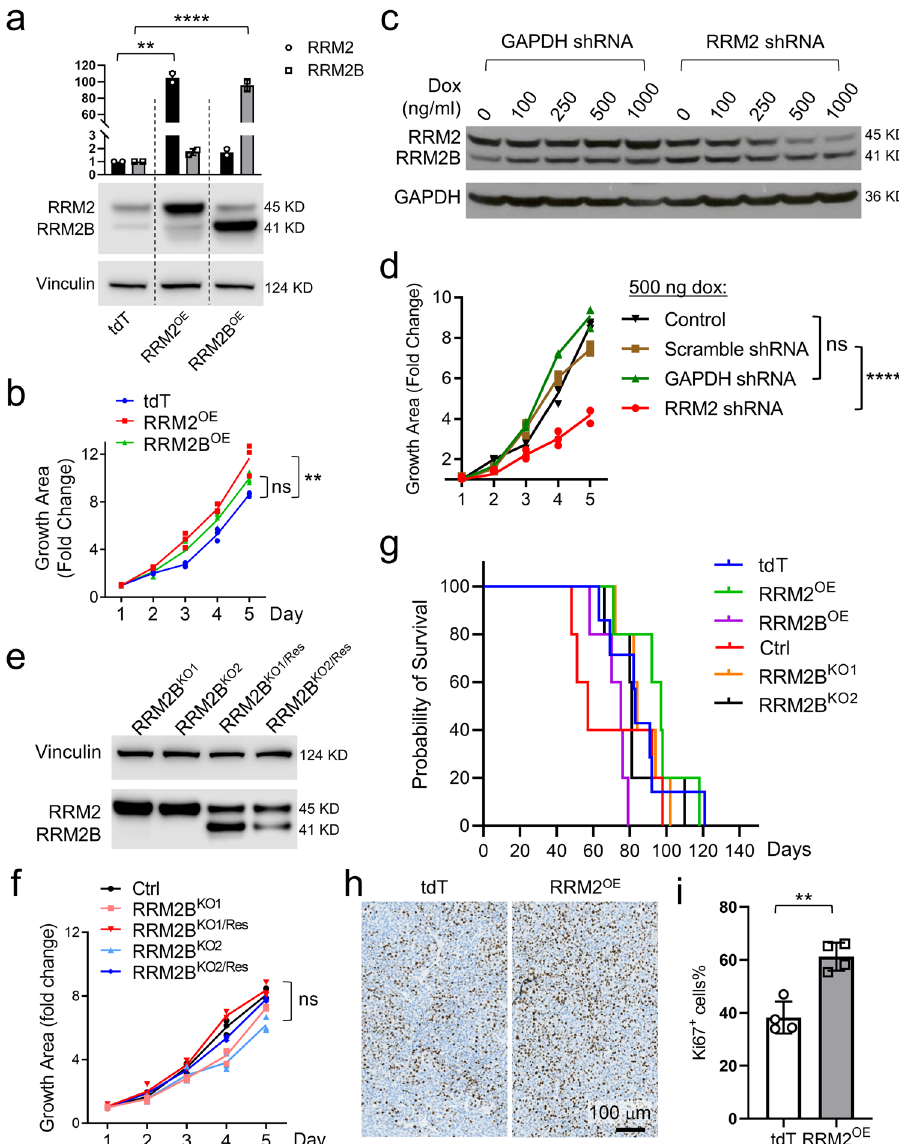
Fig. 3 RRM2, not RRM2B, supports HB cell growth in vitro and in vivo. a Quantitative RT-PCR and immunoblotting of RRM2 and RRM2B in the indicated HepG2 cells overexpressing a tdT control vector, RRM2 , or RRM2B . b Growth curves of tdT , RRM2 OE , and RRM2B OE HepG2 cells ( n = 3 for each group). c RRM2 and RRM2B immunoblotting showing a dose-dependent knockdown of RRM2 in HepG2 cells expressing a doxycycline (dox)-inducible RRM2 shRNA. GAPDH shRNA was used as a control. d Growth curves of the indicated HepG2 cells treated with 500 ng dox ( n = 3 for each group). e RRM2 and RRM2B immunoblotting in RRM2B KO and RRM2B KO/Res HepG2 cells. f Growth curves of the indicated RRM2B -manipulated HepG2 cells ( n = 3 for each group). each of the other groups). No signi fi cant statistical differences were observed between any groups. h Representative Ki67 IHC images of the tdT and RRM2